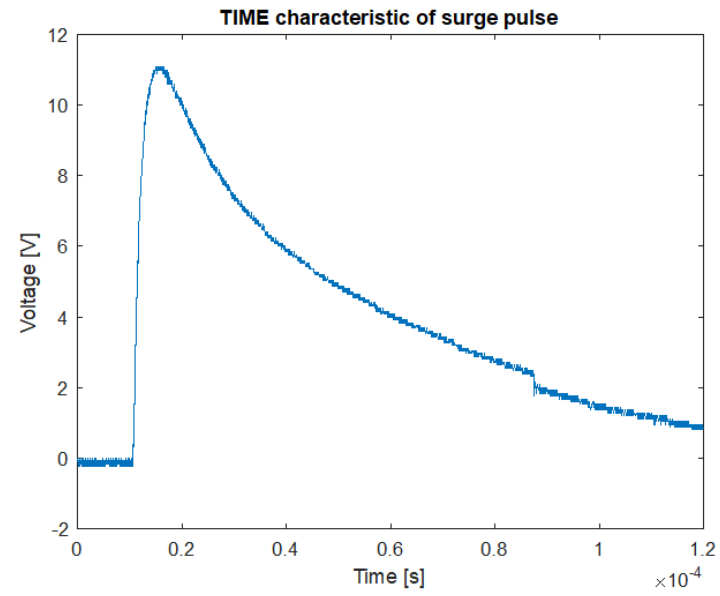
Figure 23. The shock pulse used in the model (the same as the recorded pulse from the generator shown in Section 4.1).